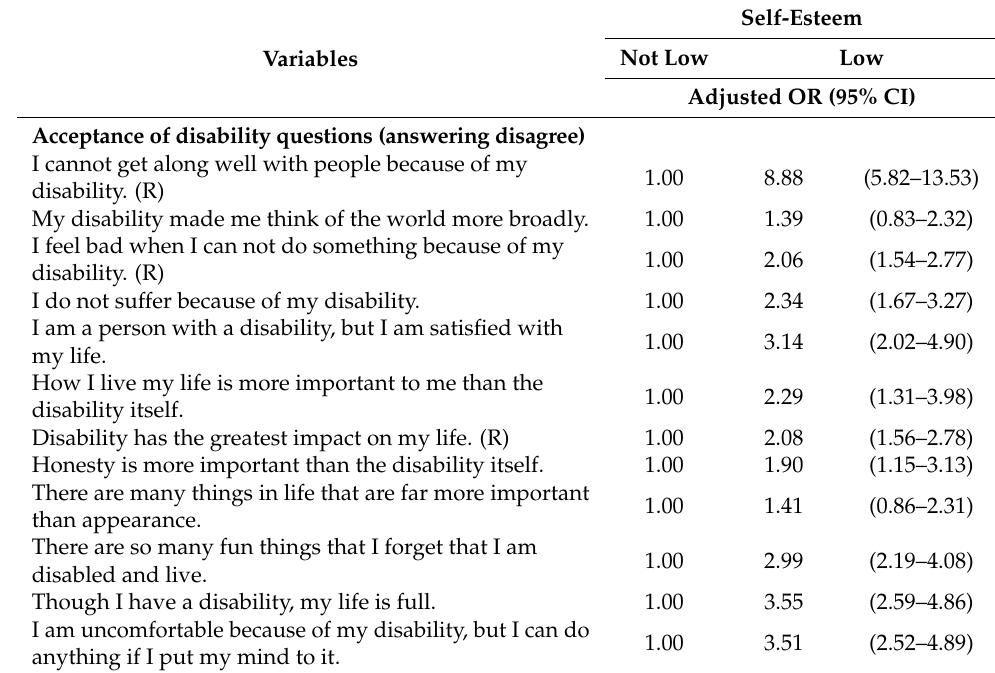
Table 4. Contents of self-esteem degree and variable of interest analysis concerning the acceptance of disability scale factors a,b,c